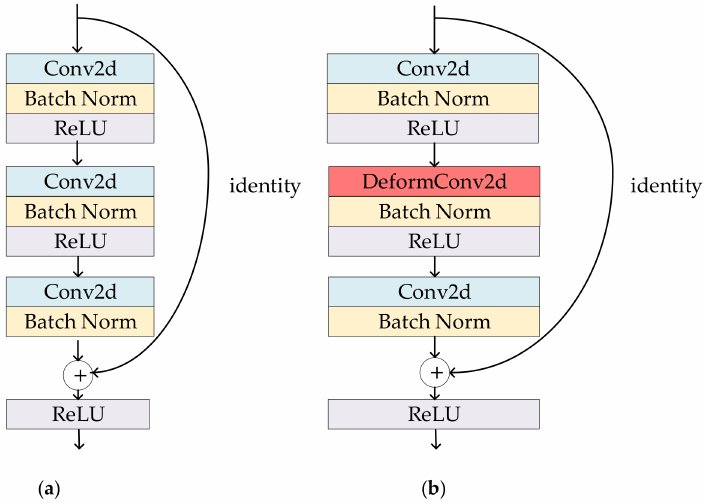
Figure 5. Architectures of ( a ) the ordinary residual block and ( b ) the proposed DCR